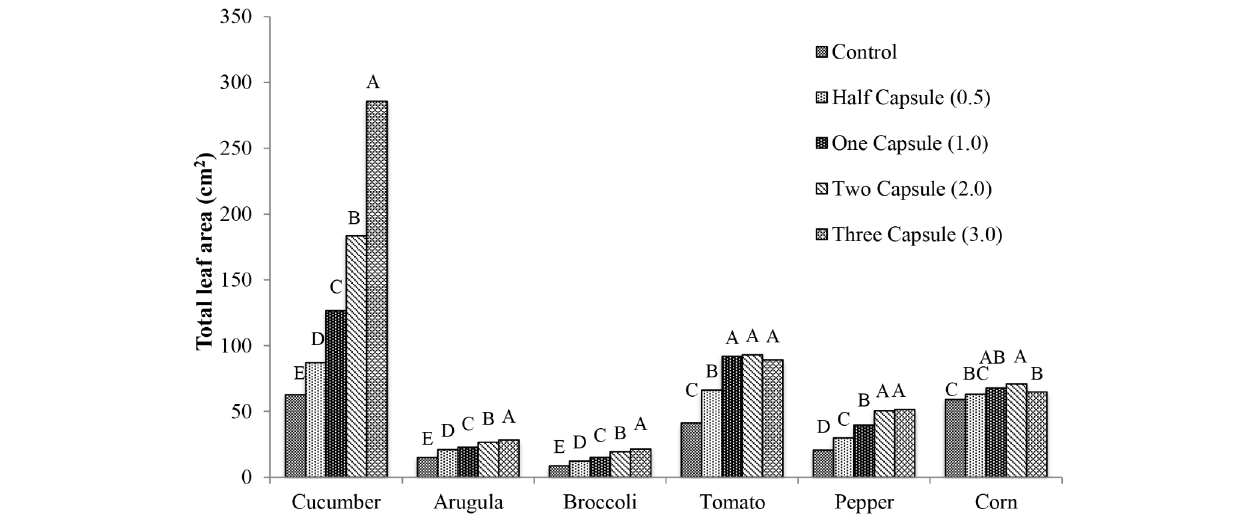
FIGURE 2 | Mean total leaf area 28 days after emergence of six crops: cucumber, arugula, broccoli, tomato, pepper, and corn with five treatments: control, half capsule (0.5), whole capsule (1.0), two capsules (2.0), and three capsules (3.0). Data analyzed by ANOVA ( α = 0.05) and Tukey’s HSD test was used to conduct mean separation comparison. Letters not associated with same letter are significantly